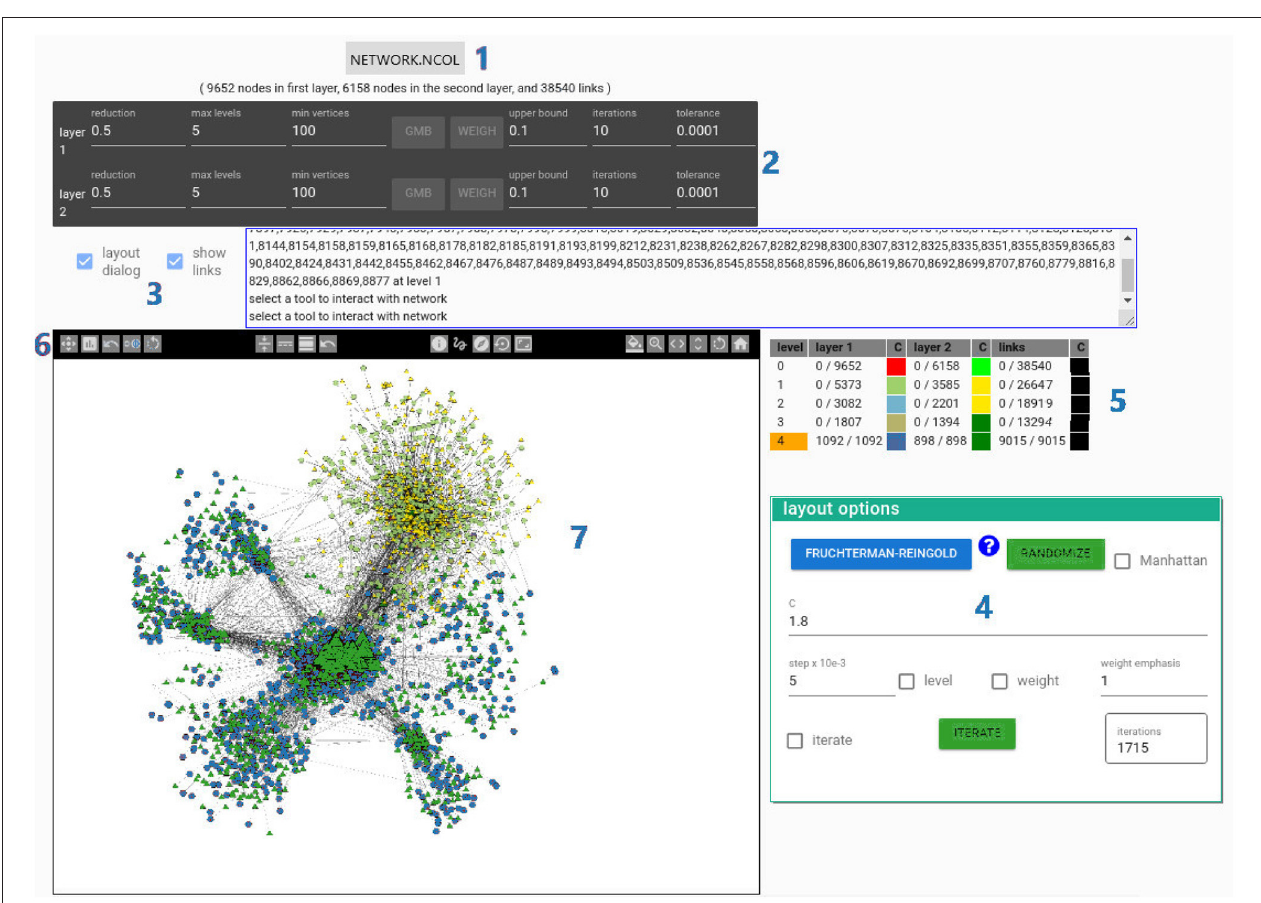
FIGURE 3 | The BiNetVis system interface: (1) drop-down menu to select a network or upload a network for analysis; (2) control widgets of the coarsening algorithm and its parameters; (3) check boxes to display the layout dialog and show/hide links and area to display user requested information on nodes or links; (4) control widget of the node-link layout algorithm; (5) interactive table panel depicting the multilevel hierarchy levels with corresponding bipartite layers; also used to set the current hierarchy view focus for interaction on the canvas; (6) toolbar with controls for network navigation and visualization; (7) canvas with the hybrid node-link network view. This view shows nodes at two distinct levels of detail, indicated by the glyph colors: level 4 (blue/green) and level 1 (light green/yellow). The current view focus is set at level 4, as indicated by the orange mark at the corresponding entry in the multilevel table panel